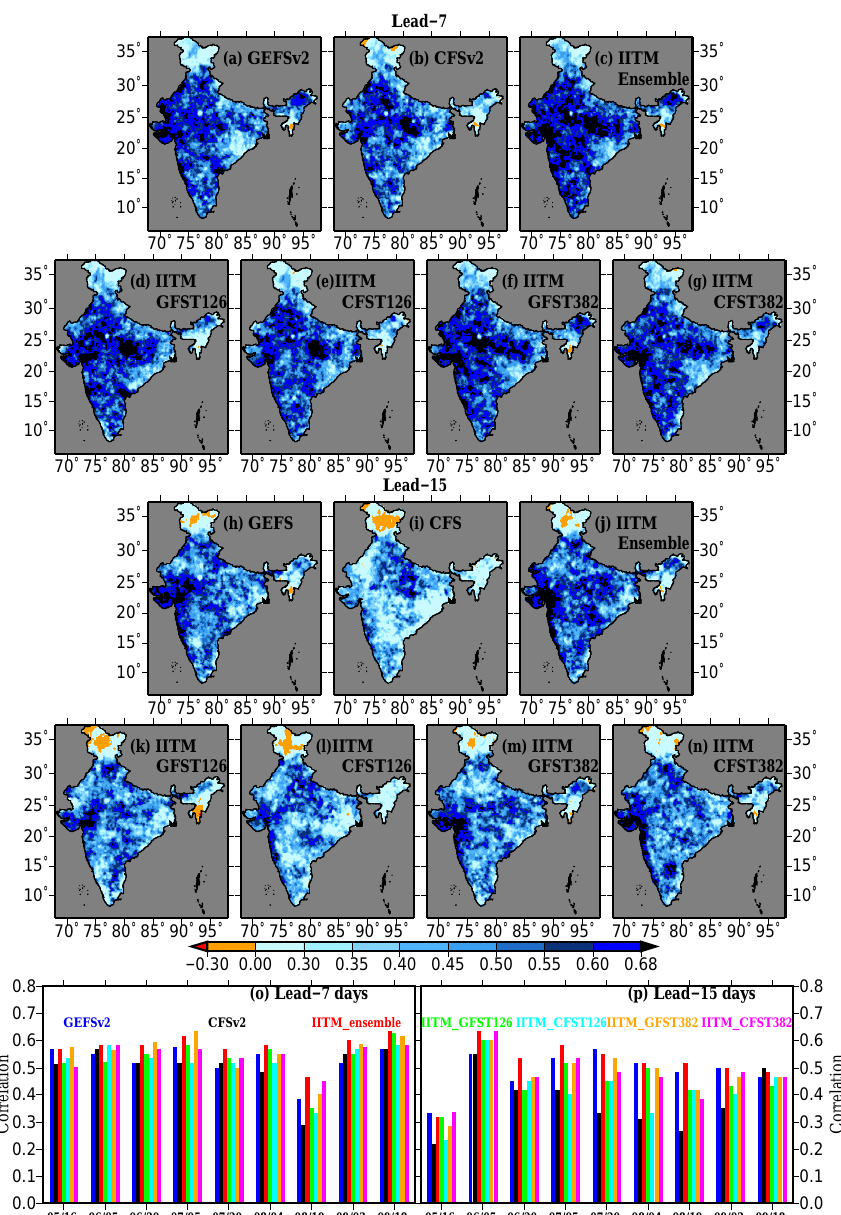
Figure 1. Correlation between precipitation forecasts and observed precipitation (OBS). (a) Correlation between precipitation forecast from the GEFSv2 accumulated up to a 7-day accumulation period and the corresponding OBS. (b) Same as (a) but for the CFSv2. (c) Same as (a) but for the IITM ensemble. (d) Same as (a) but for the IITM GFST126. (e) Same as (a) but for the IITM GFST382. (f) Same as (a) but for the IITM CFST382. (h–n) Same as (a–f) but for an accumulation period of 15 days. (o) All-India median correlation between different precipitation forecasts at a 7-day accumulation period and the corresponding OBS for the forecasts initiated on different dates. (p) Same as (o) but for an accumulation period of 15 days (period: